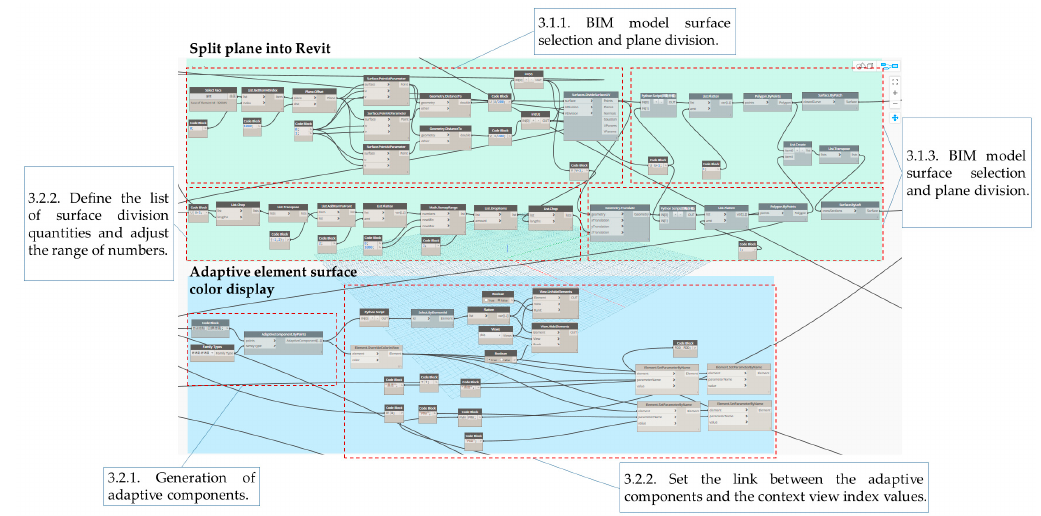
Figure 10. Adaptive components and addition of a plane in the Revit process diagram.